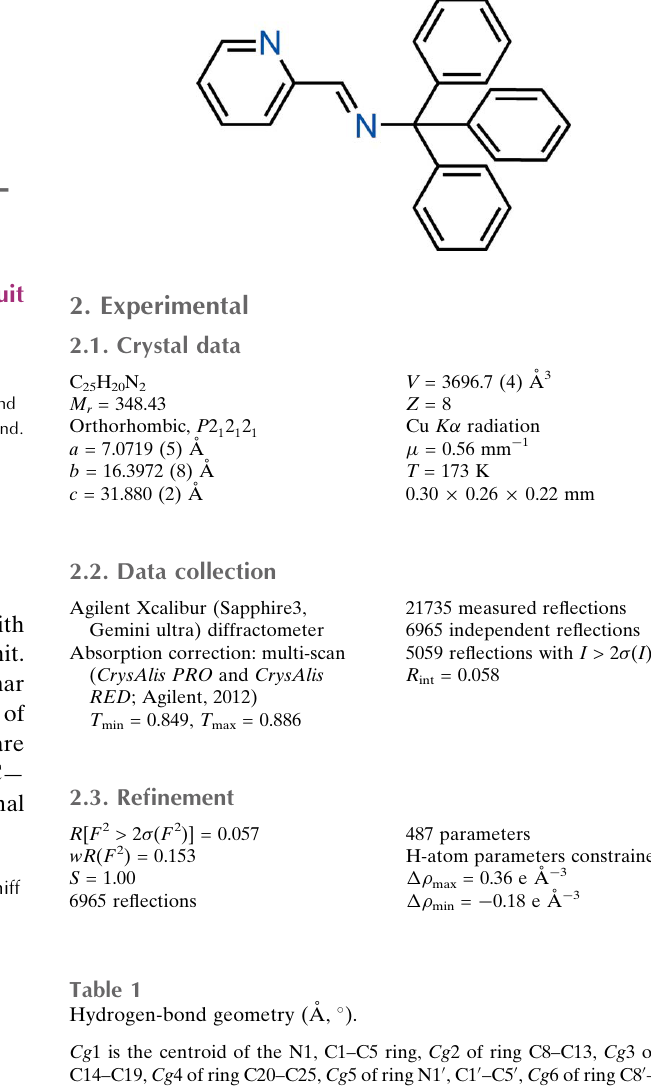
Hydrogen-bond geometry (A˚ , (cid:5)